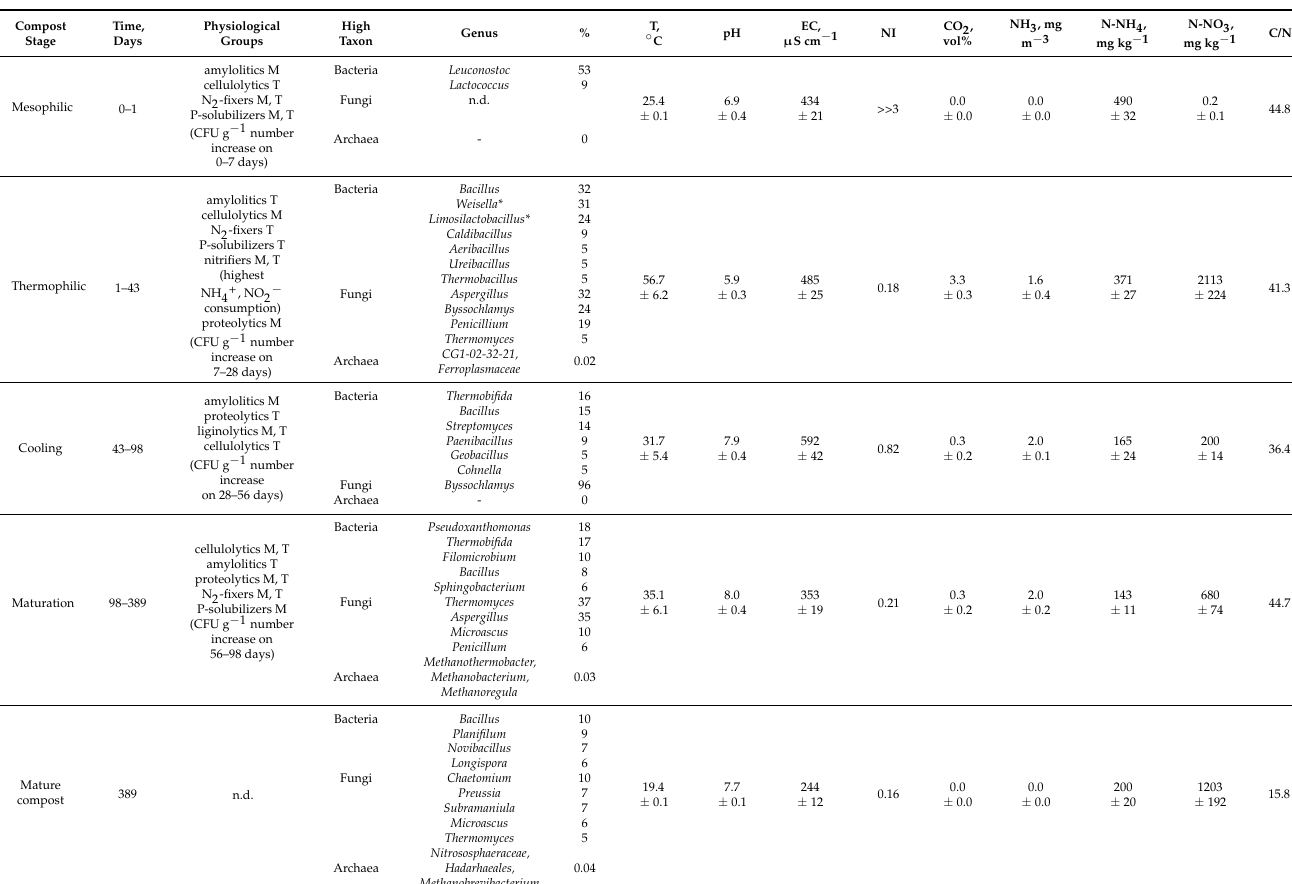
Table 4. The main physiological groups, prokaryotic and fungal genera, and physicochemical properties of the four composting stages and mature